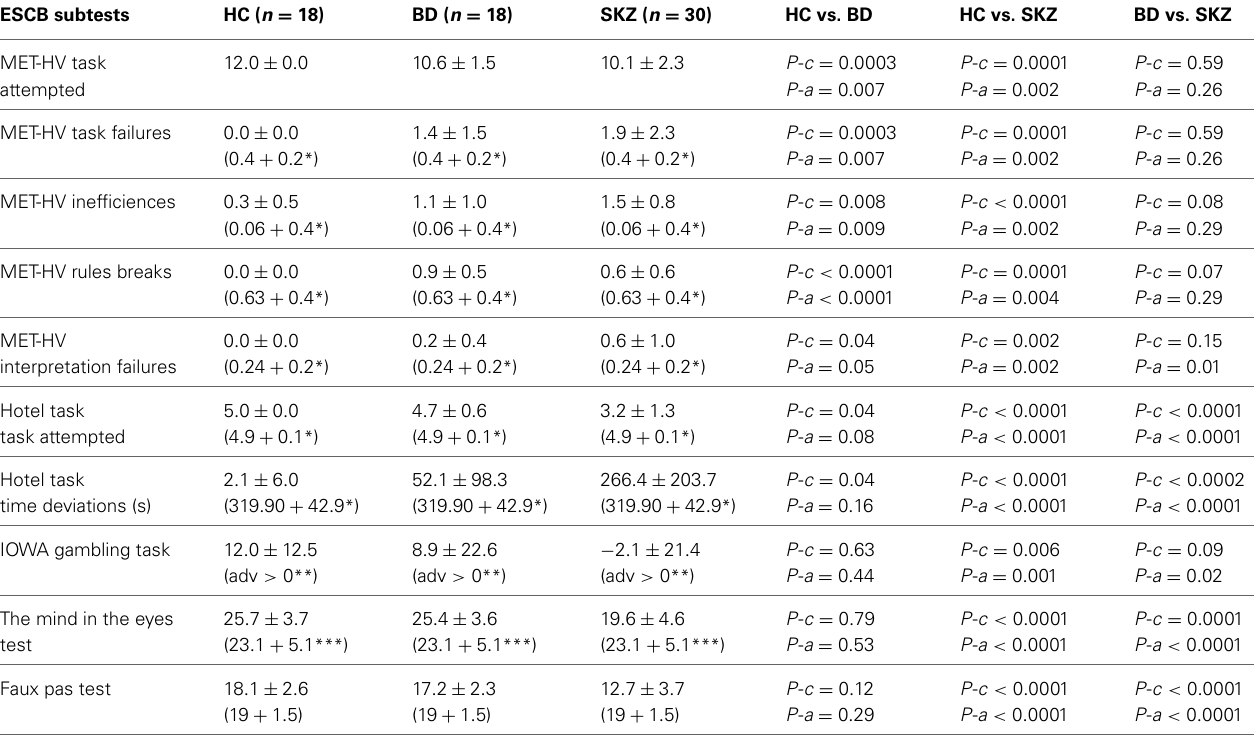
Table 3 | Performances of healthy controls (HC), bipolar disorder (BD) and schizophrenia (SKZ) patients on executive and social cognition battery (ESCB).